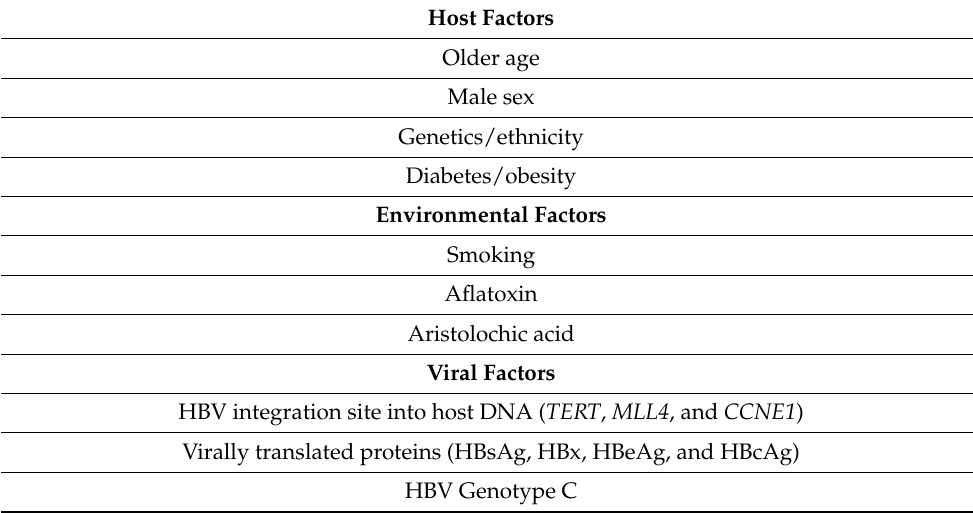
Table 2. Risk factors for development of